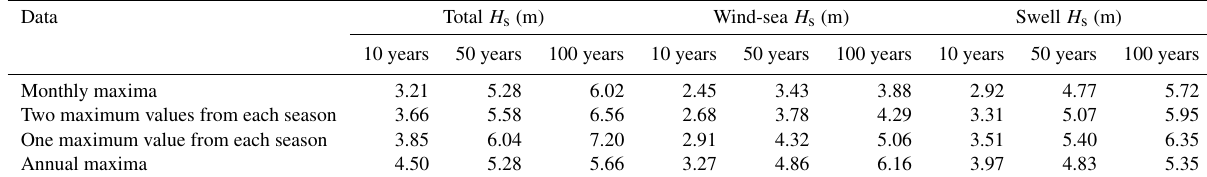
Table 5. Return levels estimated by the GEV model using total, wind-sea and swell data for different block maxima series.